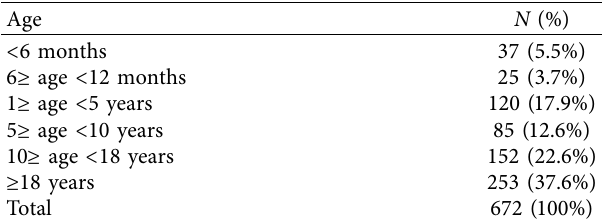
Table 2: Age distribution of suspected